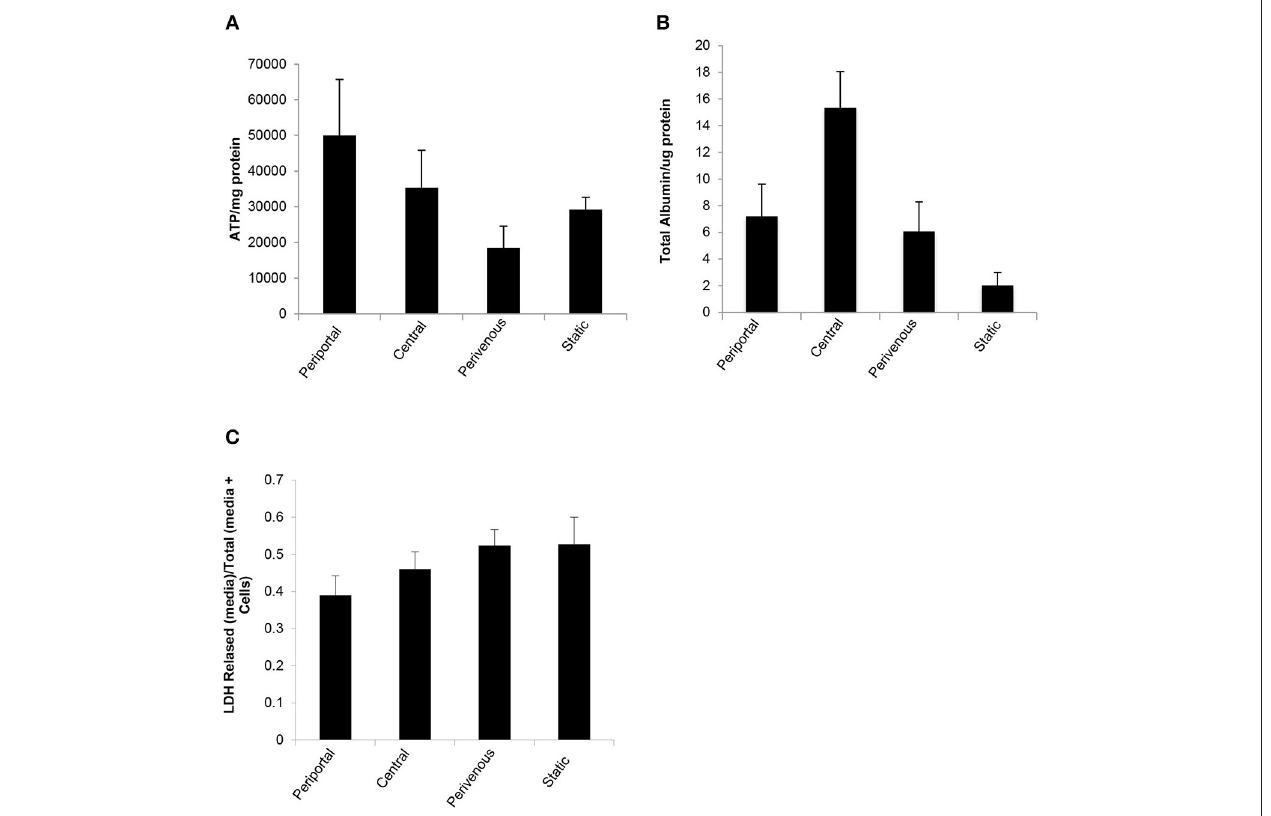
FIGURE 5 | Functional analysis of PRH in each zone compared to standard 2D static conditions. After 48h under flow conditions or static conditions functional parameters were assessed (A) ATP ( n = 4), (B) Albumin secretion ( n = 4). Both were normalized to protein concentration calculated using a Bradford assay, and (C) Cytotoxicity of shear stress analyzed by LDH assay. Data shown as LDH released (in media)/Total LDH (present in cells +